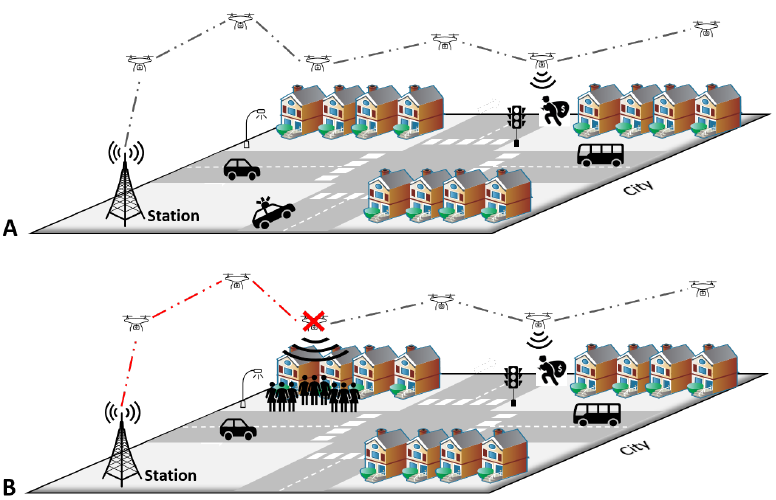
Figure 5. A MWSN scenario. ( A ) Illustration depicting a scenario without uncertainty, ( B ) system failure due to introduction of human